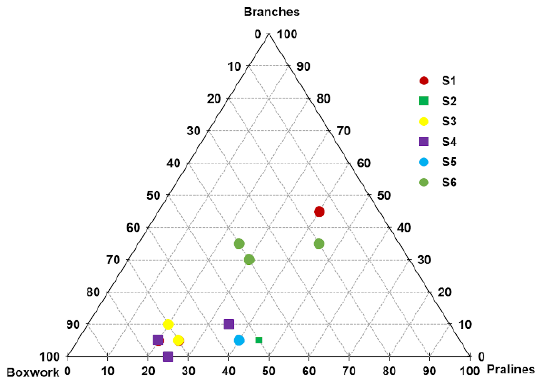
Figure 8. Ternary plot of the three identified morphotypes from the grab samples.